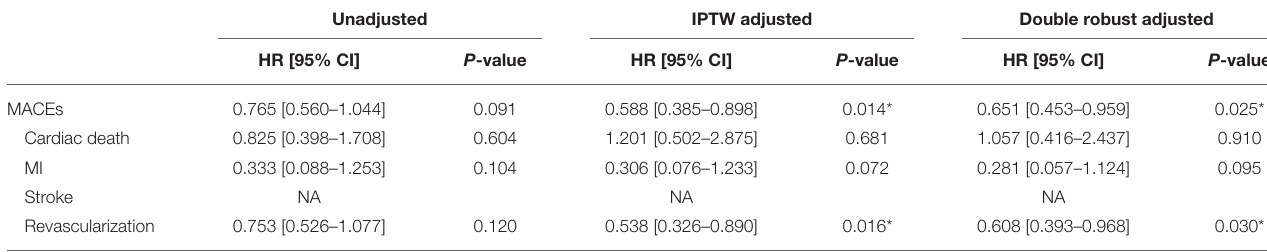
TABLE 5 | Cox regression analysis of metoprolol treatment on MACEs and its components in unadjusted, IPTW adjusted, and double robust adjusted population. Unadjusted